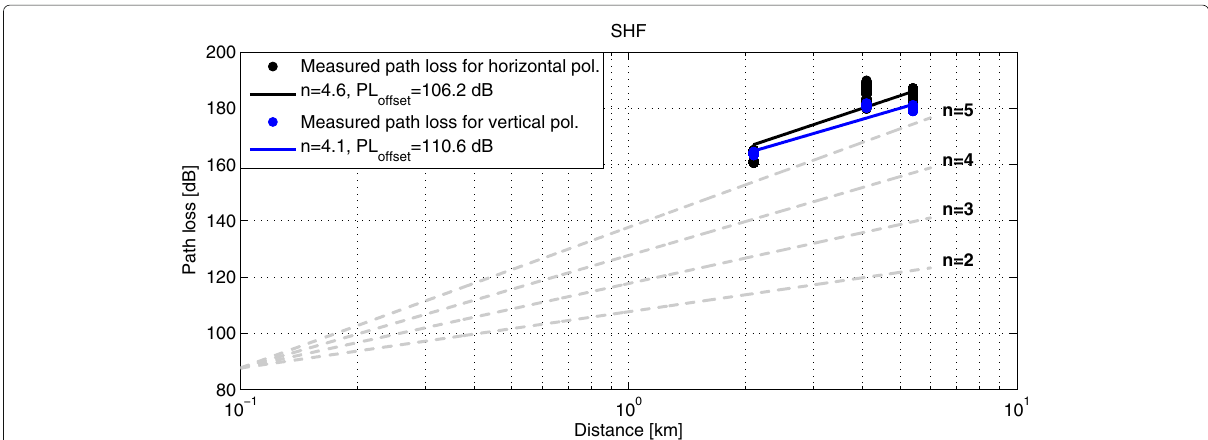
Fig. 8 The measured path loss for 5.8 GHz center frequency of the outdoor non-line of sight environment. The black and blue circles represent the measured non-line of sight path loss values for horizontal and vertical co-polarizations,